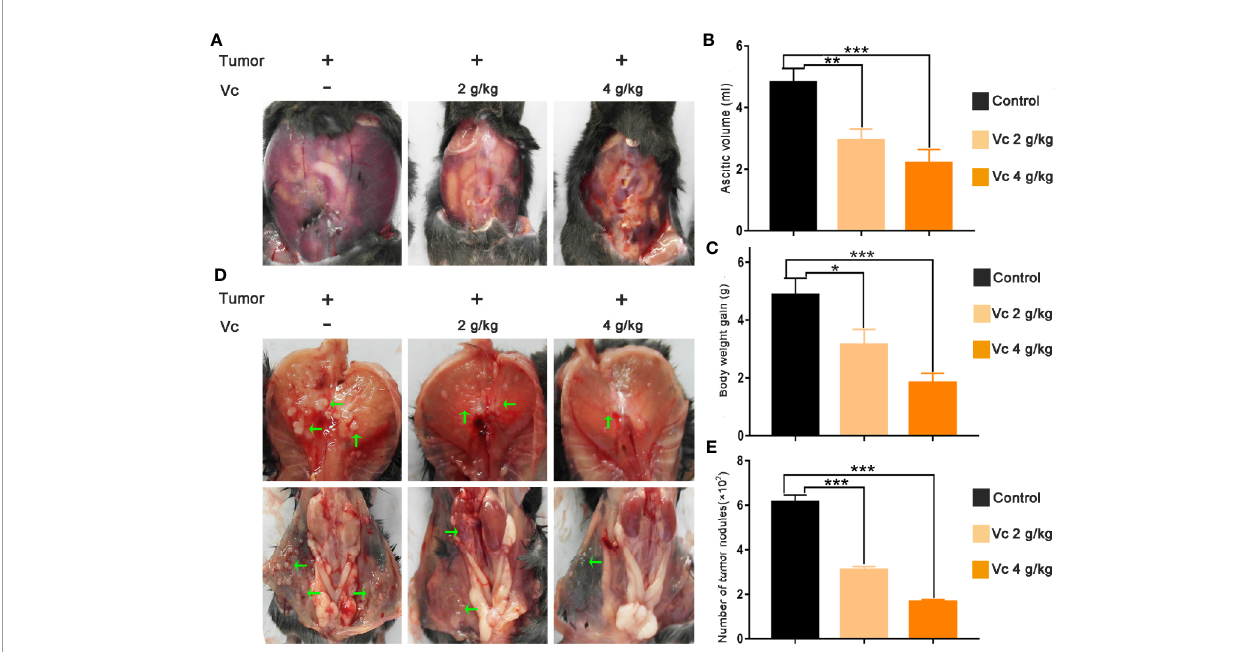
FIGURE 1 | Vitamin C reduces intraperitoneal metastasis and malignant ascites in mice bearing ID8 ovarian cancer. (A) Representative images of bloody ascites derived in peritoneal cavity from control and vitamin C treatment groups. (B) Ascites volume in different groups. (C) Body weight gain in different groups. (D) Representative images of tumor nodules in diaphragm and peritoneal wall. (E) Metastatic dissemination in diaphragm and peritoneal wall was assessed by counting metastatic colonies in individual mice. Data are expressed as the mean ± SEM; n=8 mice per group for one out of three independent experiment. *p < 0.05, **p < 0.01, ***p <